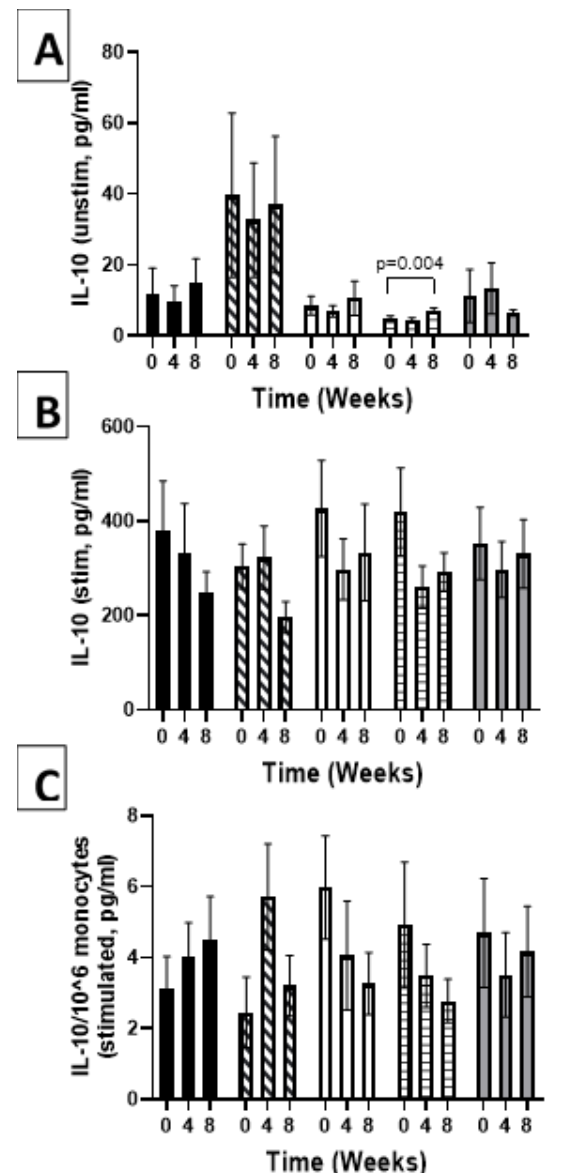
Figure 6. Plasma IL-10 without stimulation ( A ) and with lipopolysaccharide stimulation ( B ). ( C ) Stimulated samples normalized to monocyte numbers. Values are mean ± SEM, n = 15 per group. Significant changes are indicated where p < 0.05.